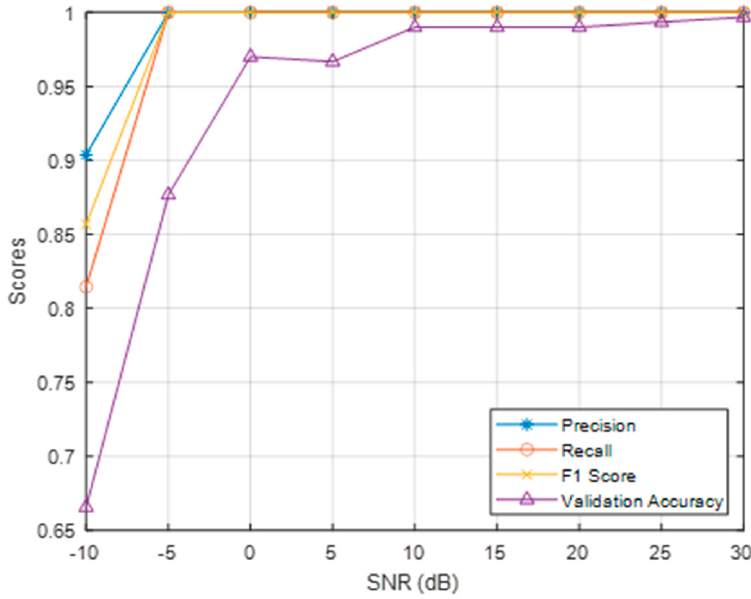
Figure 8. Performance of AP-CNN.